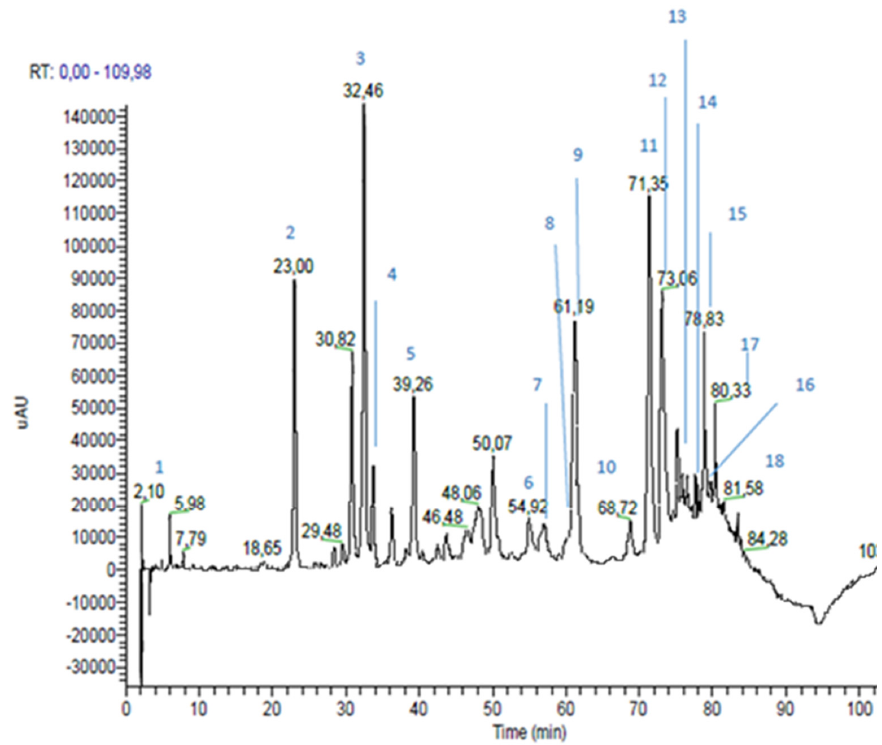
Figure 2. Brown propolis extract chromatogram, registered at 330 nm.